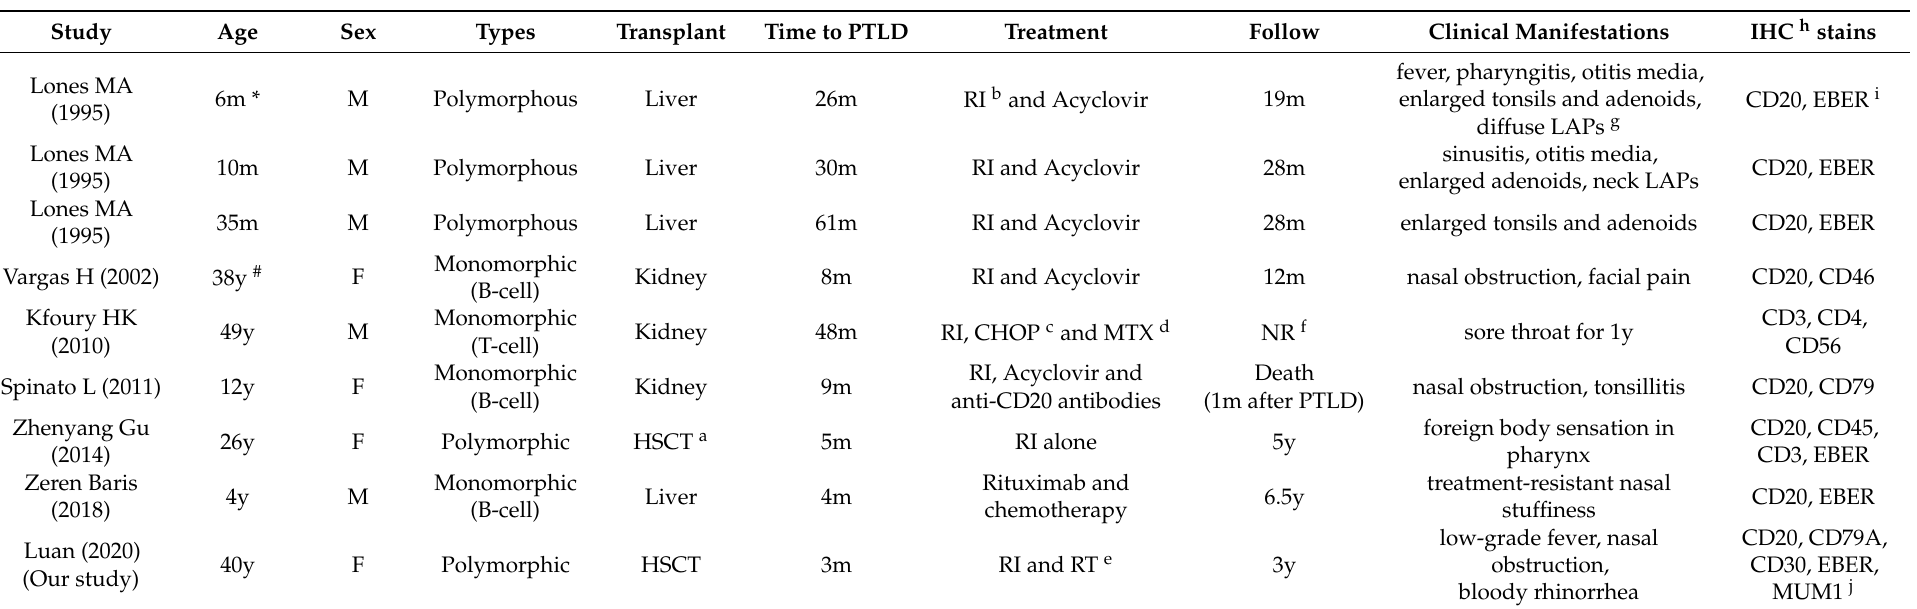
Table 1. Summary of published studies on PTLD in the